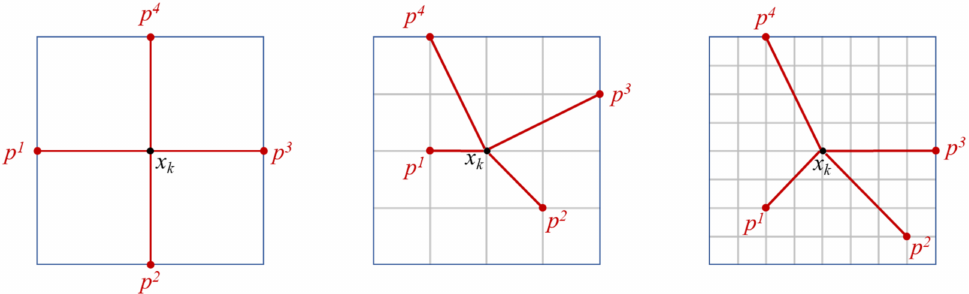
Figure 2. Examples of MADS reference